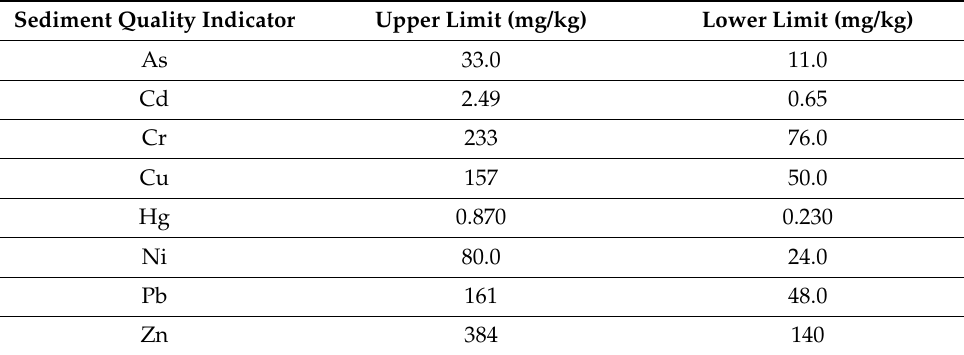
Figure 3. Box-and-whisker plot analysis of Cu concentration in irrigation canal sediment sampling sites in various counties and cities in Taiwan. The number in the parentheses is the number of sampling sites in a city/county. Table 1. The lower and upper limit values of sediment quality guidelines for heavy